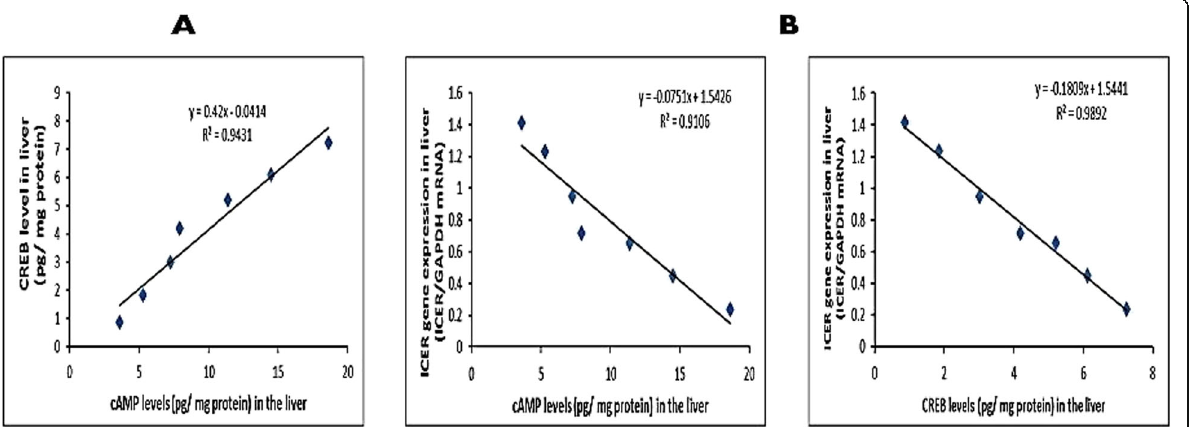
Fig. 2 Spearman correlation studies during the induction of NAFLD. a Correlation between cAMP and CREB levels. b Correlation between ICER gene expression level with cAMP and CREB levels ( P <